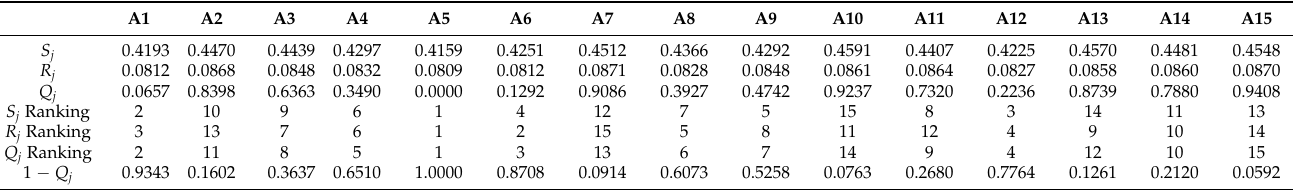
Table 14. Sorting results of